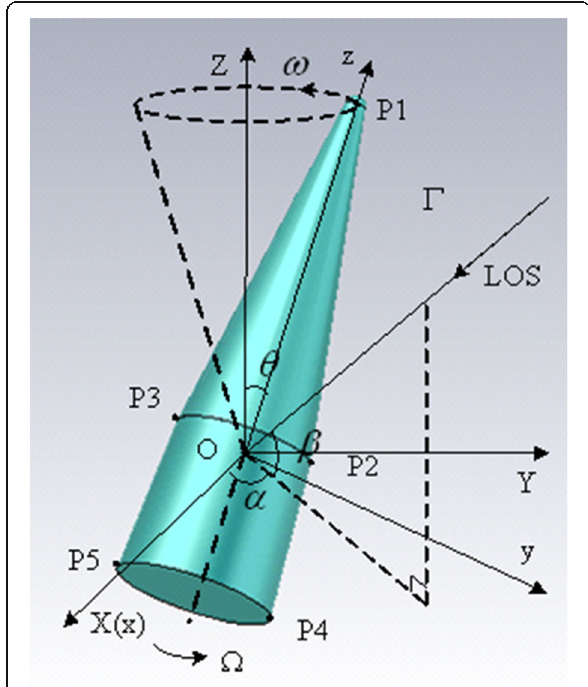
Fig. 1 The diagram of a precession model in CST